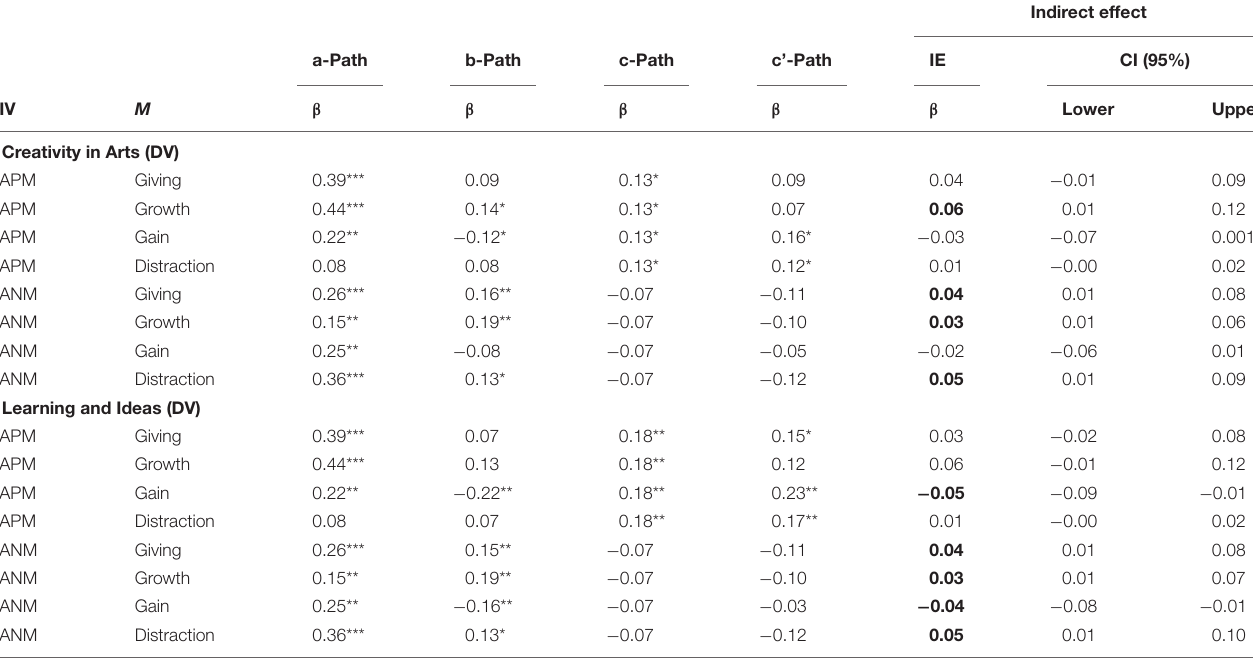
TABLE 9 | Results of the mediation analysis of the effects of moods on change in creativity through motivation in Germany ( n =